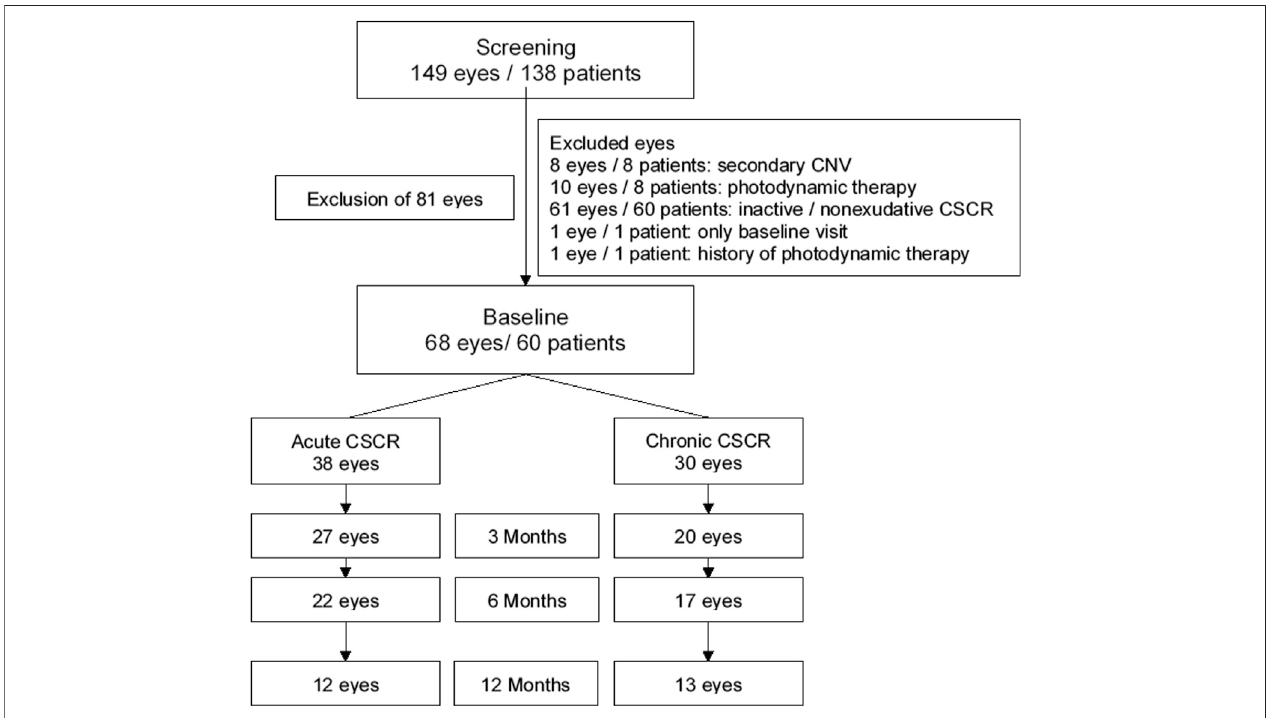
FIGURE 1 | Consort style fl ow diagram of data collection and follow-up. CNV – choroidal neovascular membrane, CSCR central serous chorioretinopathy.